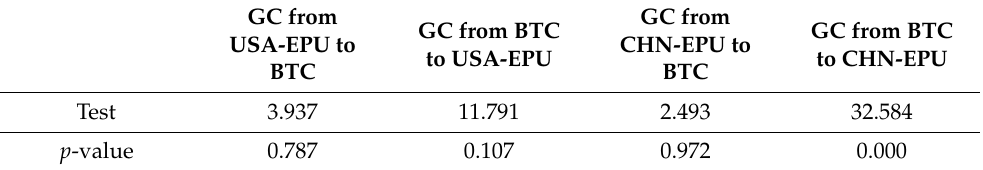
Table 2. TY Granger causality test.